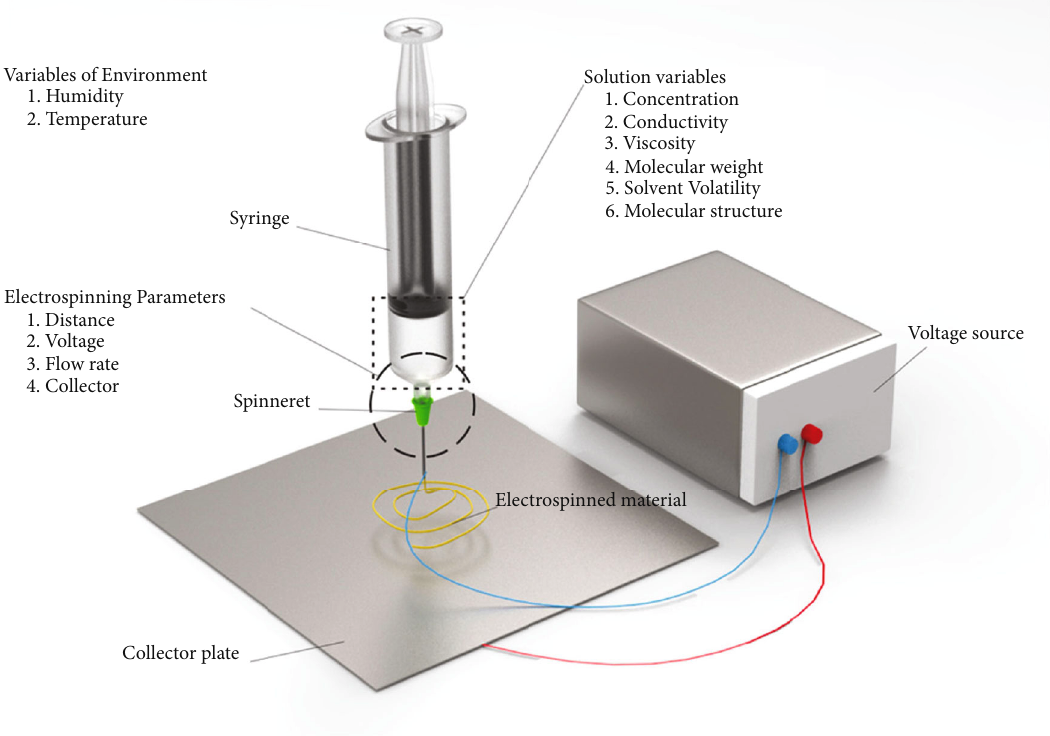
Figure 1: Schematic of the electrospinning principle and controlling